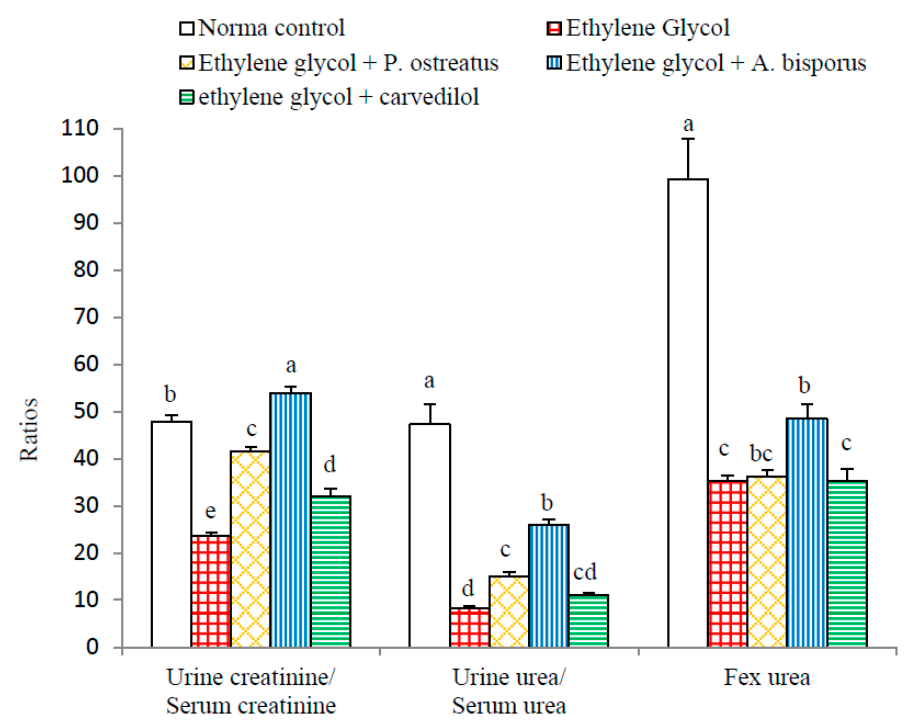
Figure 7. Effect of P. ostreatus and A. bisporus aqueous extracts and carvedilol on various ratios related to kidney function of ethylene glycol-administered rats. For each parameter, means which share the same letter(s) are not significantly different.